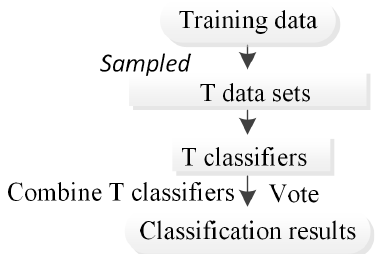
Figure 5. Flowchart of the bagging method.